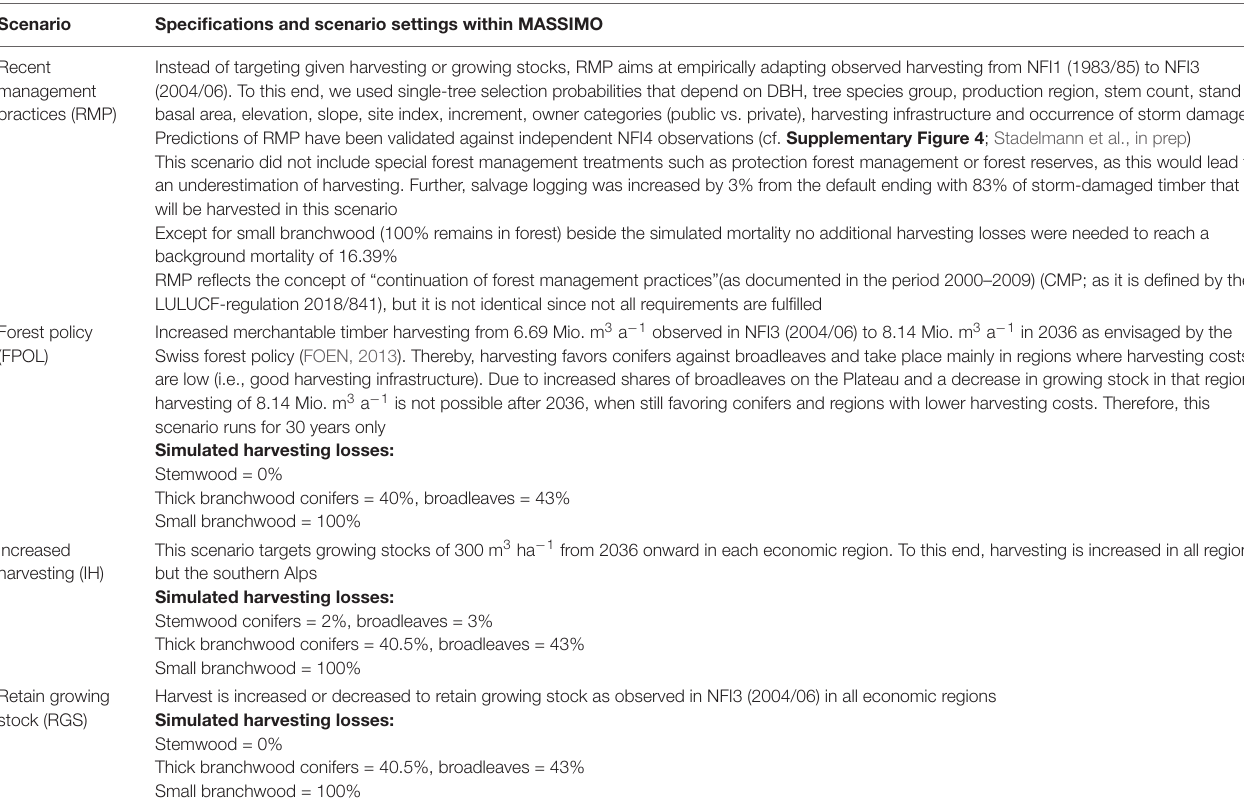
TABLE 1 | Scenarios used to drive simulations of forest development with